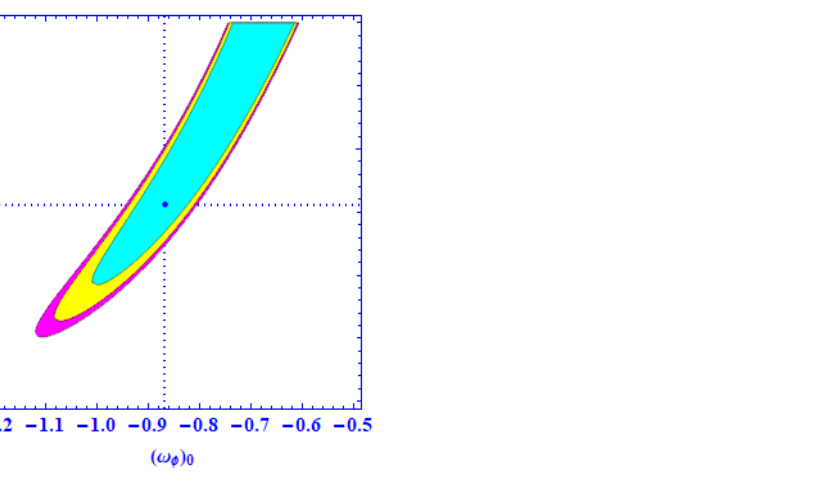
Figure 5. Two-dimensional contours in the ( ω φ ) 0 − ( Ω φ ) 0 plane at 1 σ , 2 σ and 3 σ confidence regions by bounding our model with joint H ( z ) and BAO data.